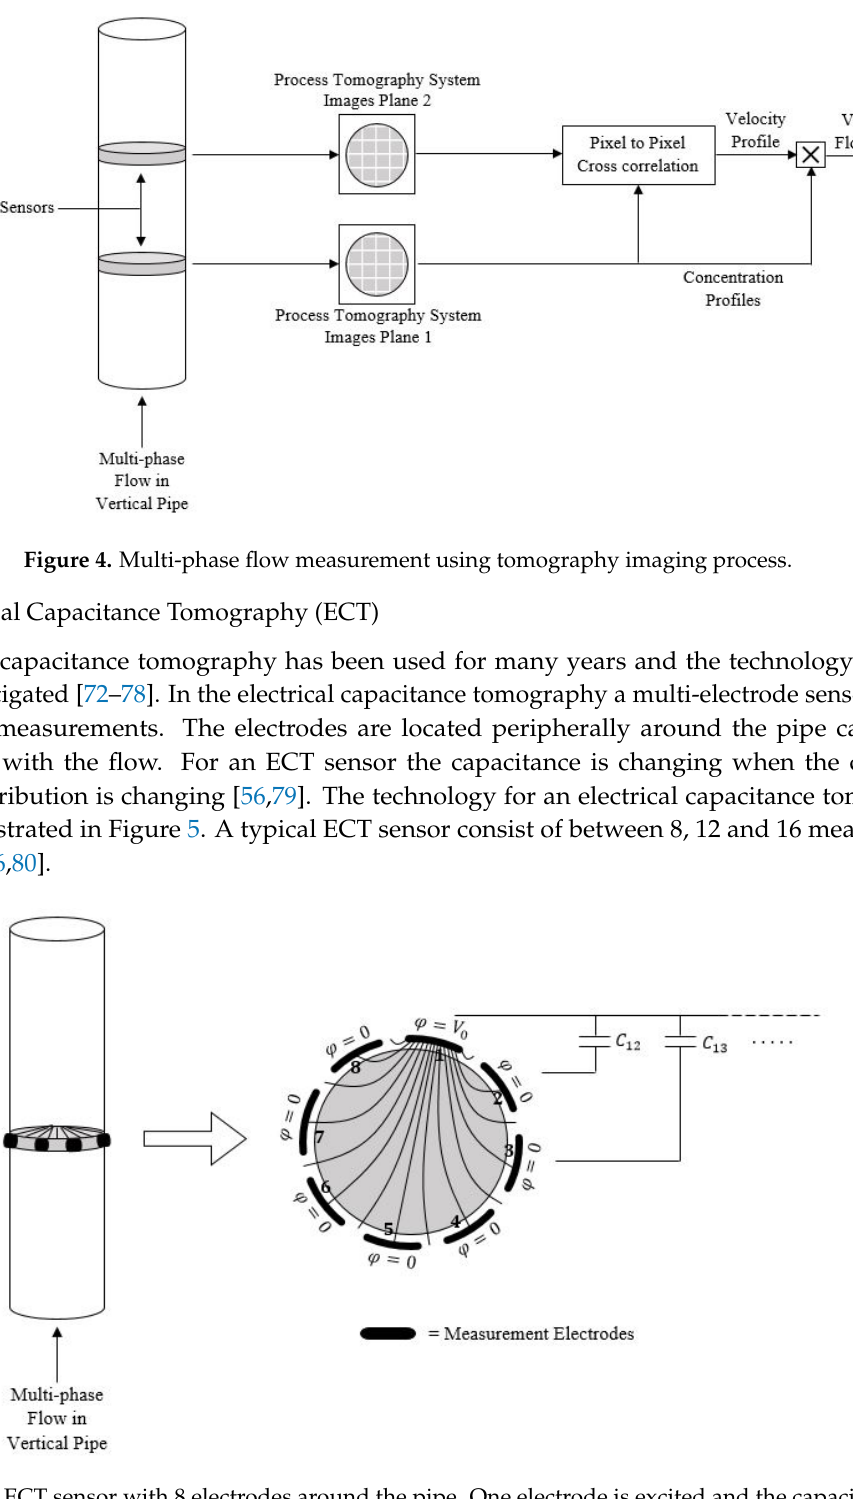
Figure 5. ECT sensor with 8 electrodes around the pipe. One electrode is excited and the capacitance is